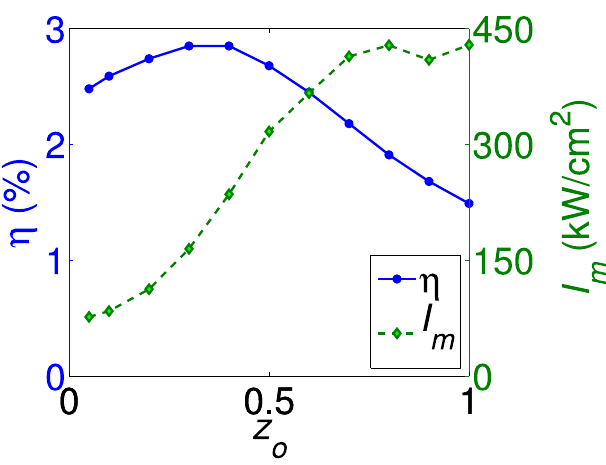
FIG. 6. (Color) Simulation results for extraction (cid:10) versus nor- (solid blue line). The optimum value malized Rayleigh length z 0 (cid:6) 0 : 3 , in agreement with the simple theory, but good is z 0 . Also plotted extraction is maintained for smaller values of z 0 is the intensity on the mirrors (dashed green line); the intensity decreases dramatically as the Rayleigh length is reduced.